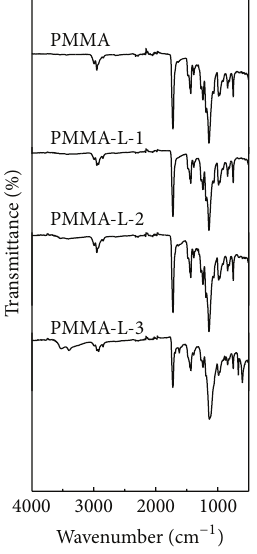
Figure 2: The FTIR spectra of composite samples.